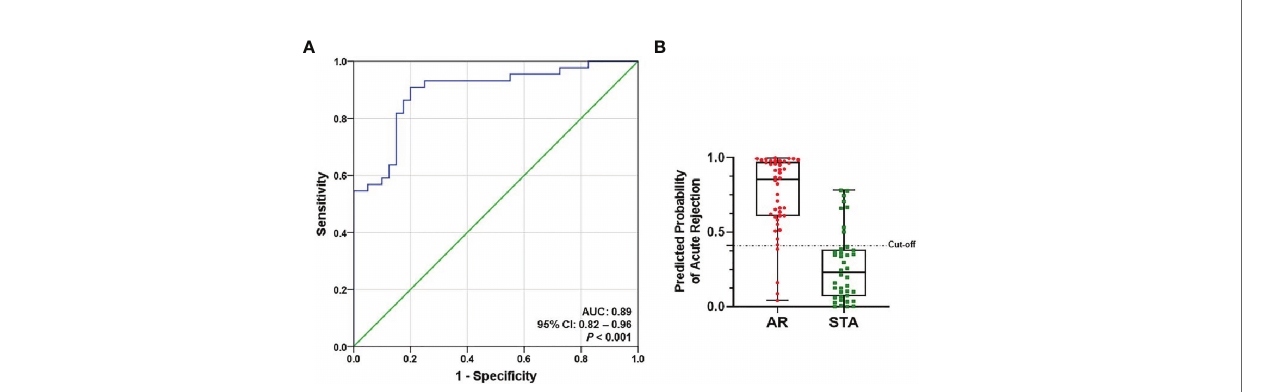
FIGURE 3 | ROC curve analysis of the signature to distinguish AR from STA in the training set. The graphs of receiver operating characteristic (ROC) curves and the predicted probability of AR for the six-genes signature show discrimination of AR from STA. (A) The area under the curve (AUC) value of the six-gene model is 0.89 (95% CI, 0.82-0.96; P<0.001). (B) In the graph of the predicted probability of AR with the cutoff point (0.40889), the signature yielded 86% accuracy, 91% sensitivity, 80% speci fi city, 83% positive predictive value (PPV), and 89% negative predictive value (NPV).